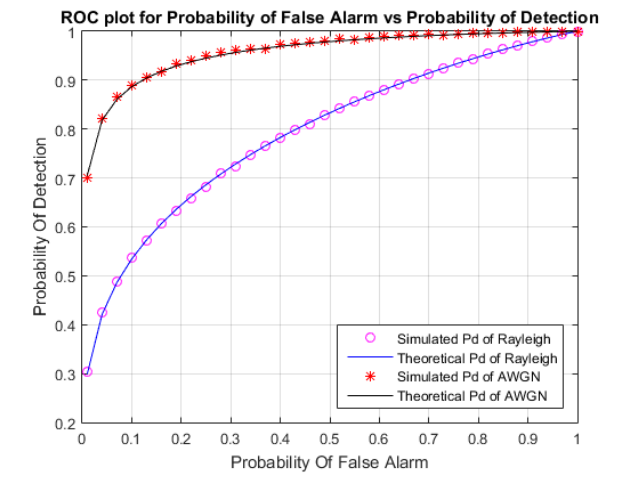
Figure 3. P D versus P F of fading and non -fading channels